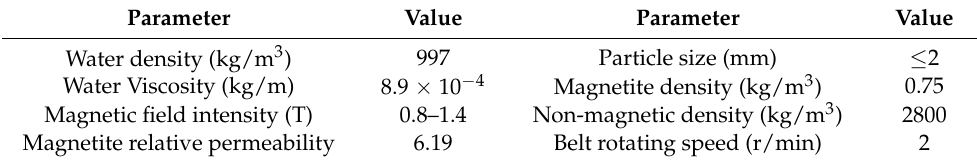
Figure 3. Model meshing. Table 1. Main parameters of simulation. Table 1. Main parameters of simulation.